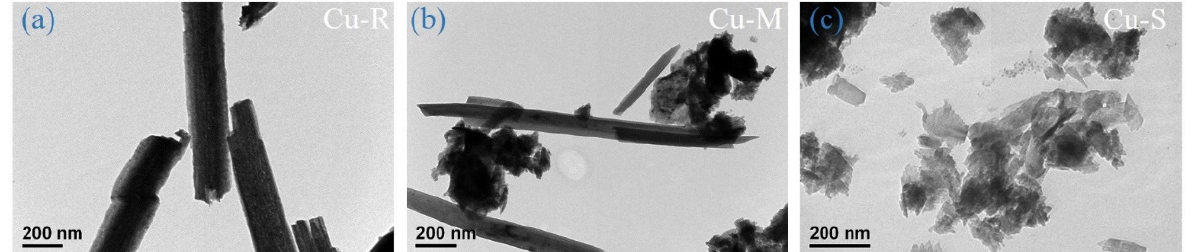
Figure 2. FETEM images of ( a ) Cu-R, ( b ) Cu-M, and ( c ) Cu-S.